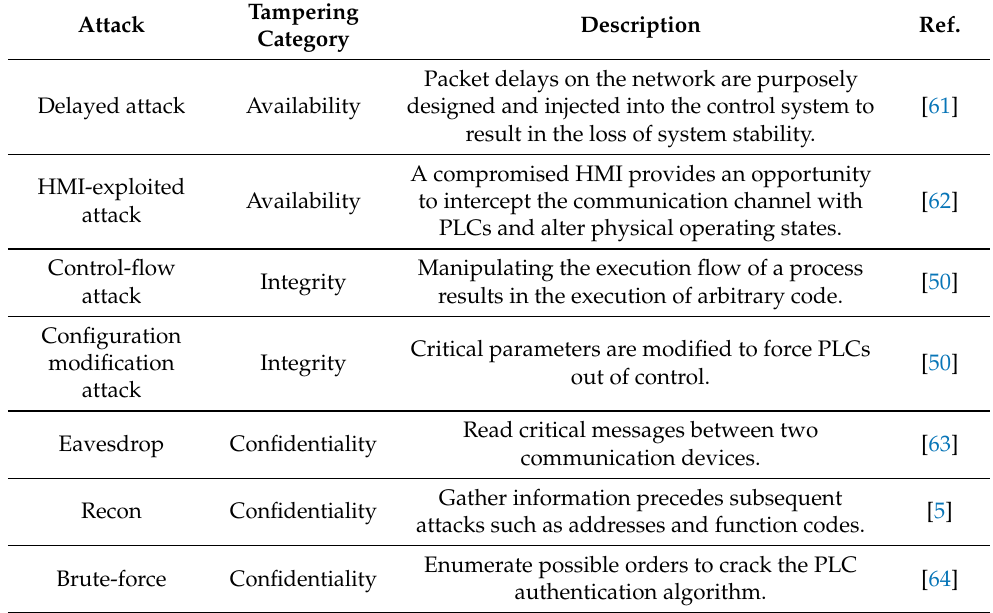
Table 2. Brief summaries on the remaining